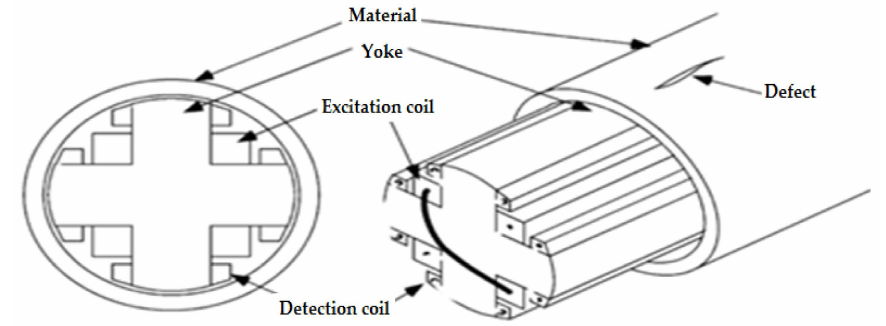
Figure 10. Rotating magnetic flux sensor for pipe and tube inspection.